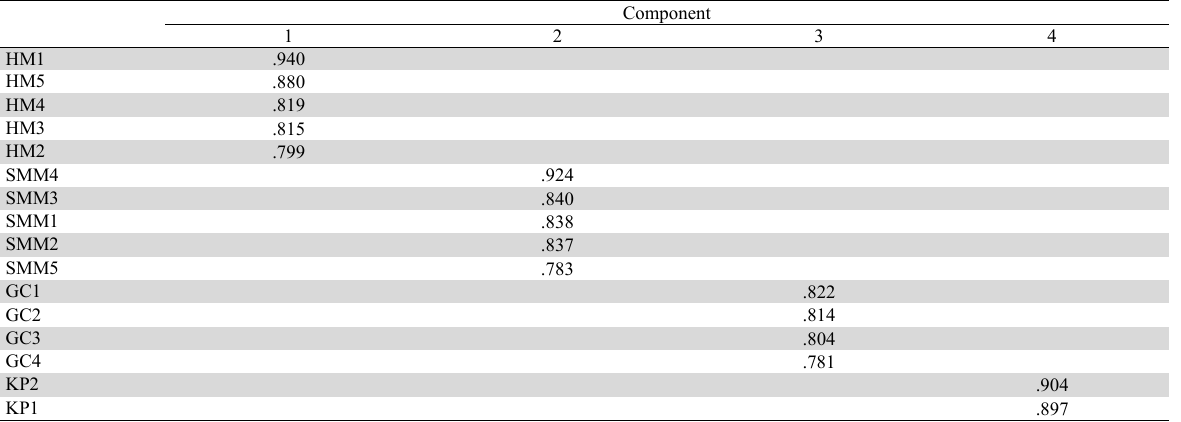
The results of rotated component matrix